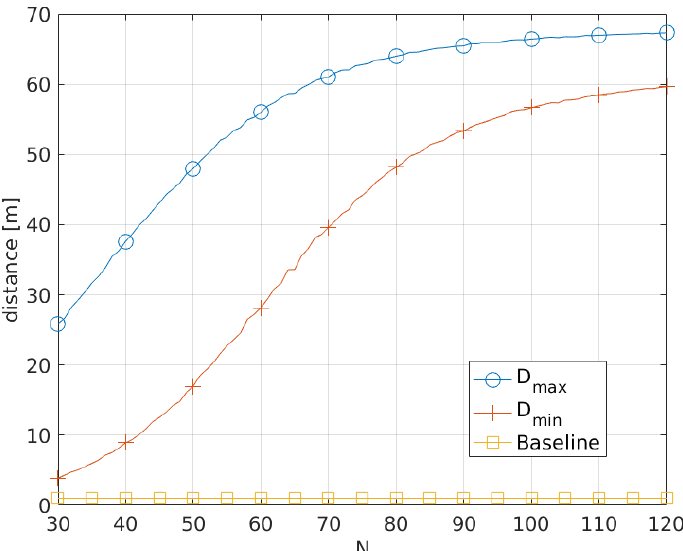
Figure 6. Average maximum and minimum obfuscation distance for UE-A, as a function of the number of UEs N in the considered area. N UEs are uniformly randomly dropped in an area of 100 m × 100 m. UE-A is at the center of the square area and only UEs closer than 15 m communicate directly. The baseline is a distance of 1 m, indicating the position accuracy in the absence of a